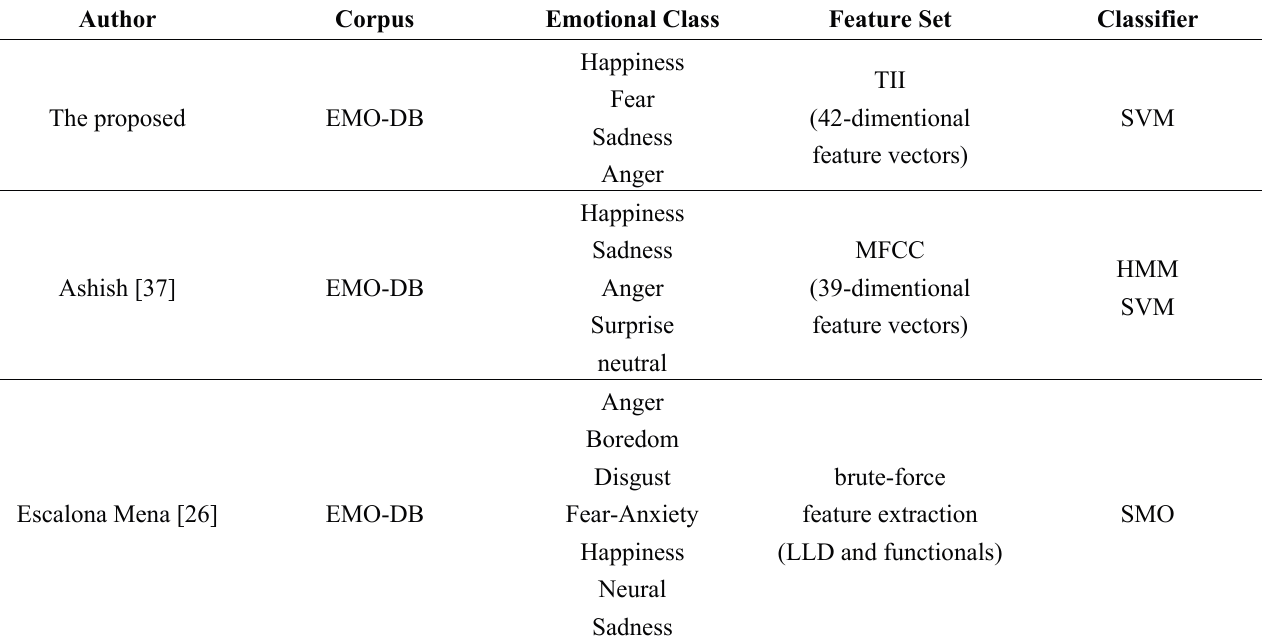
Table 9. A comparison between the proposed method and some existing